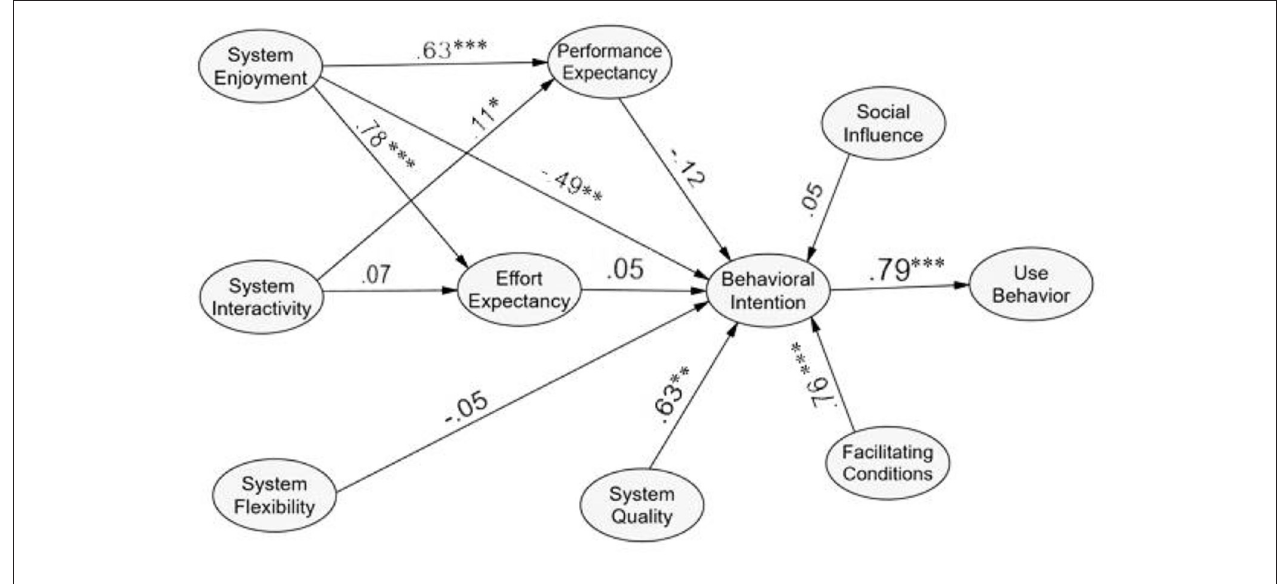
FIGURE 3 | The final study.